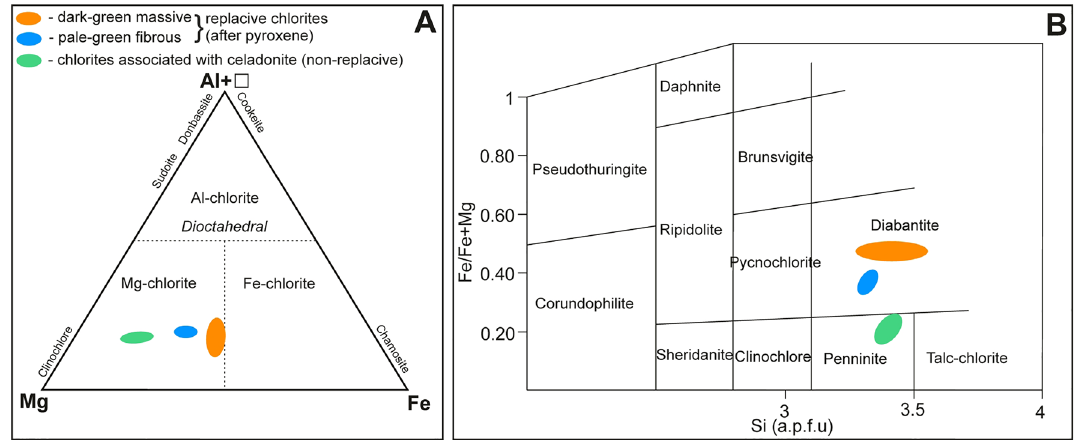
Figure 9 . ( A ) Al + □ –Mg–Fe compositional classification diagram for replacive chlorites and chlorites associated with celadonite (non-replacive)—after 38 . Note that □ corresponds to the octahedral vacancy. ( B ) Fe/ (Fe + Mg) versus Si (in a.p.f.u.) classification plot of replacive chlorites and non-replacive chlorites associated with celadonite—after 39 .